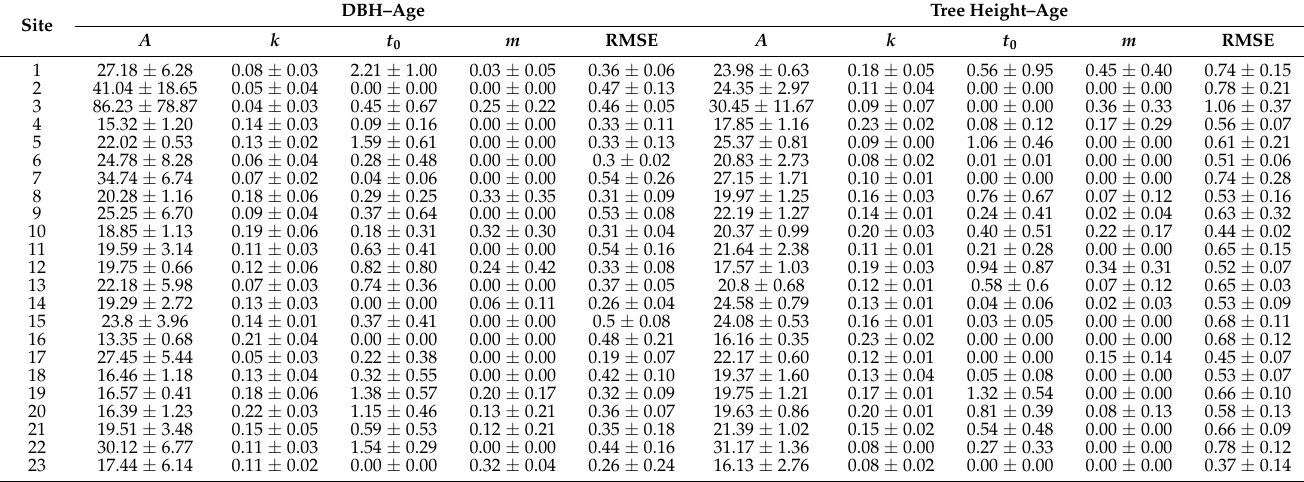
Table A2. Individual tree growth curve parameters of Richards growth function. RMSE: root mean square error. A (upper limit of tree growth), k (curvature of tree growth curve or intrinsic growth speed), t 0 (initial tree growth) and m (shape of growth) are fitted tree growth curve